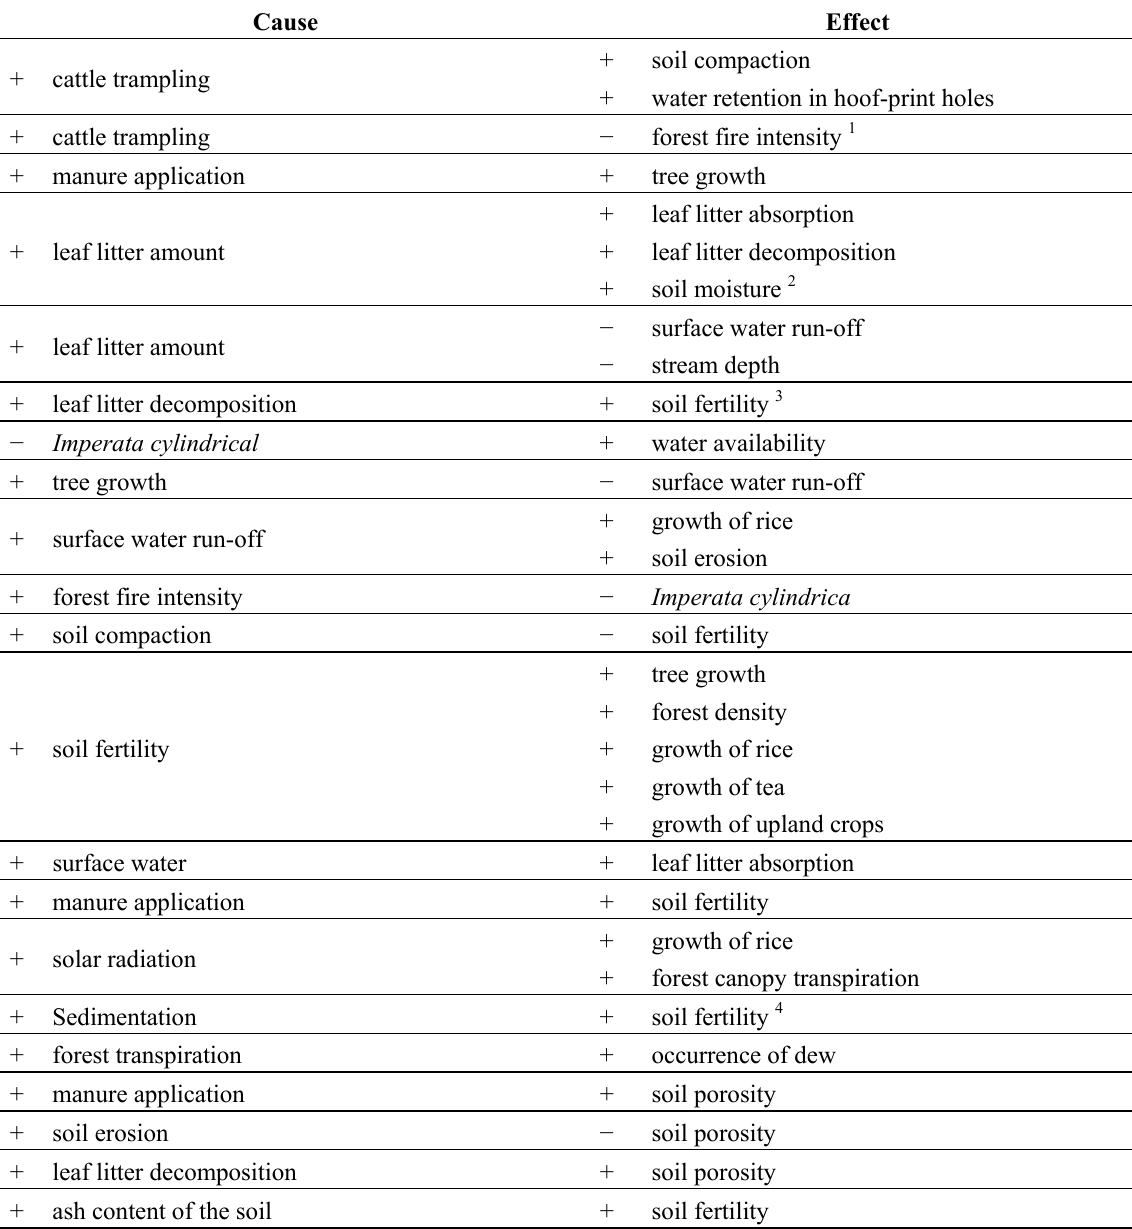
Table 1. Local statements regarding cause-and-effect relationships in nutrient